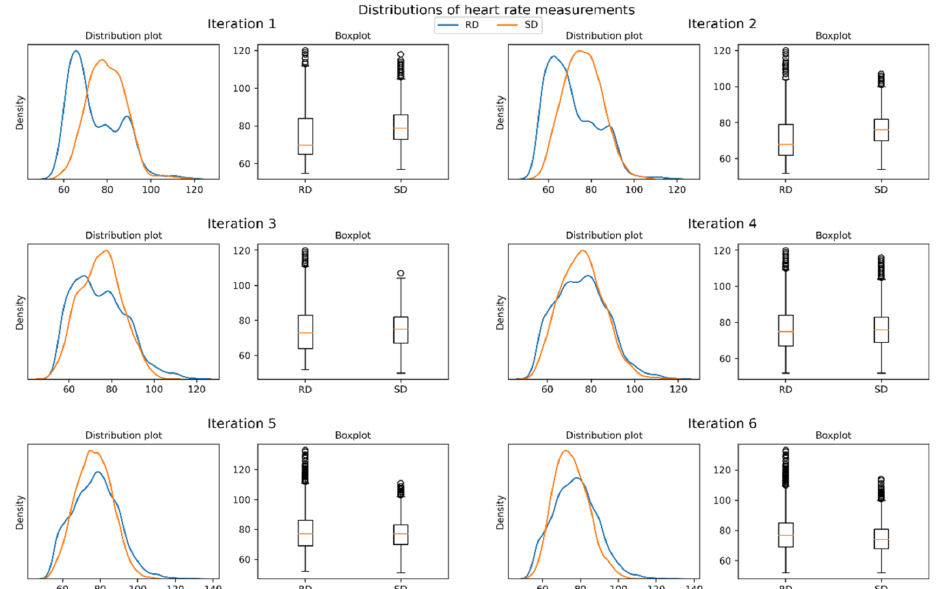
Figure 6. Visual Comparison of heart rate measurements distribution for RD and SD. Each pair of plots corresponds to one iteration. On the left of each iteration, the distribution plot of both RD and SD heart rate measurements is shown. In the right of each iteration, the boxplots of both RD and SD heart rate measurements can be